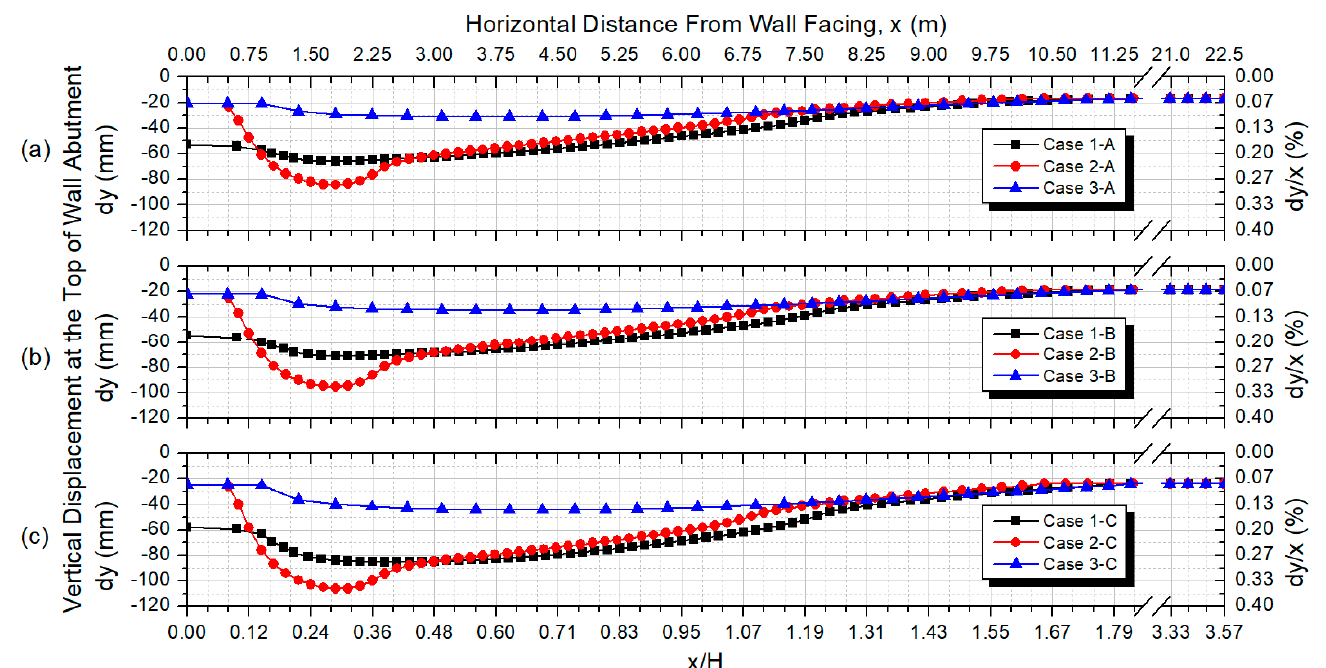
Figure 9. Vertical displacements at the top of the wall abutment, dy (mm): ( a ) Case 1A, 2A 3A (end of bridge construction); ( b ) Case 1B, 2B, 3B (general traffic loading); and ( c ) Case 1C, 2C, 3C (railway loading).